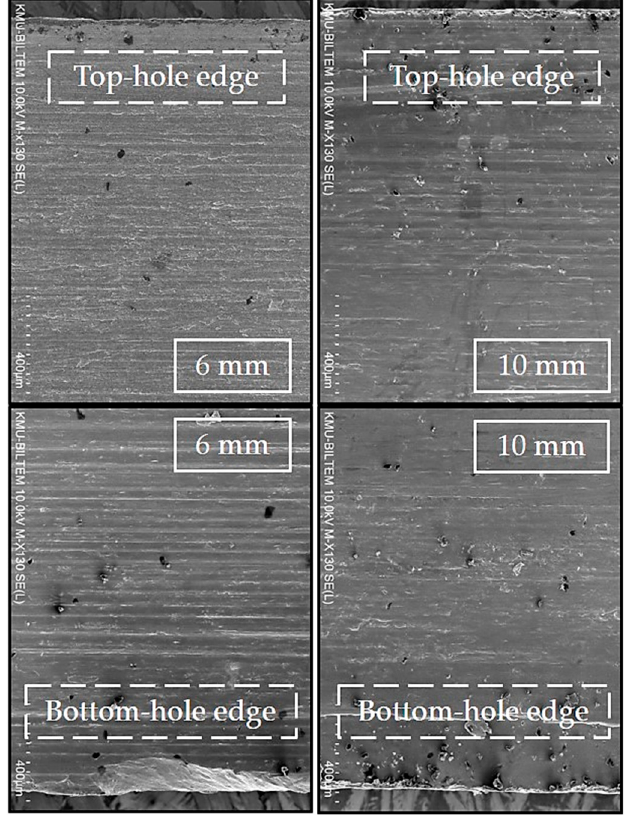
Figure 5. Borehole condition under SEM at 1000 rpm and 0.04 mm/rev.